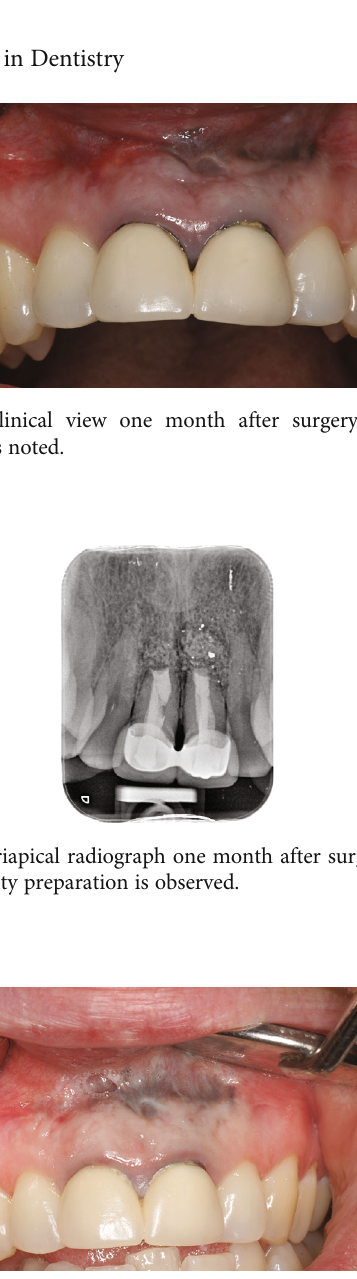
Figure 21: Clinical view 6 months after surgery, showing improvement of the soft tissues.